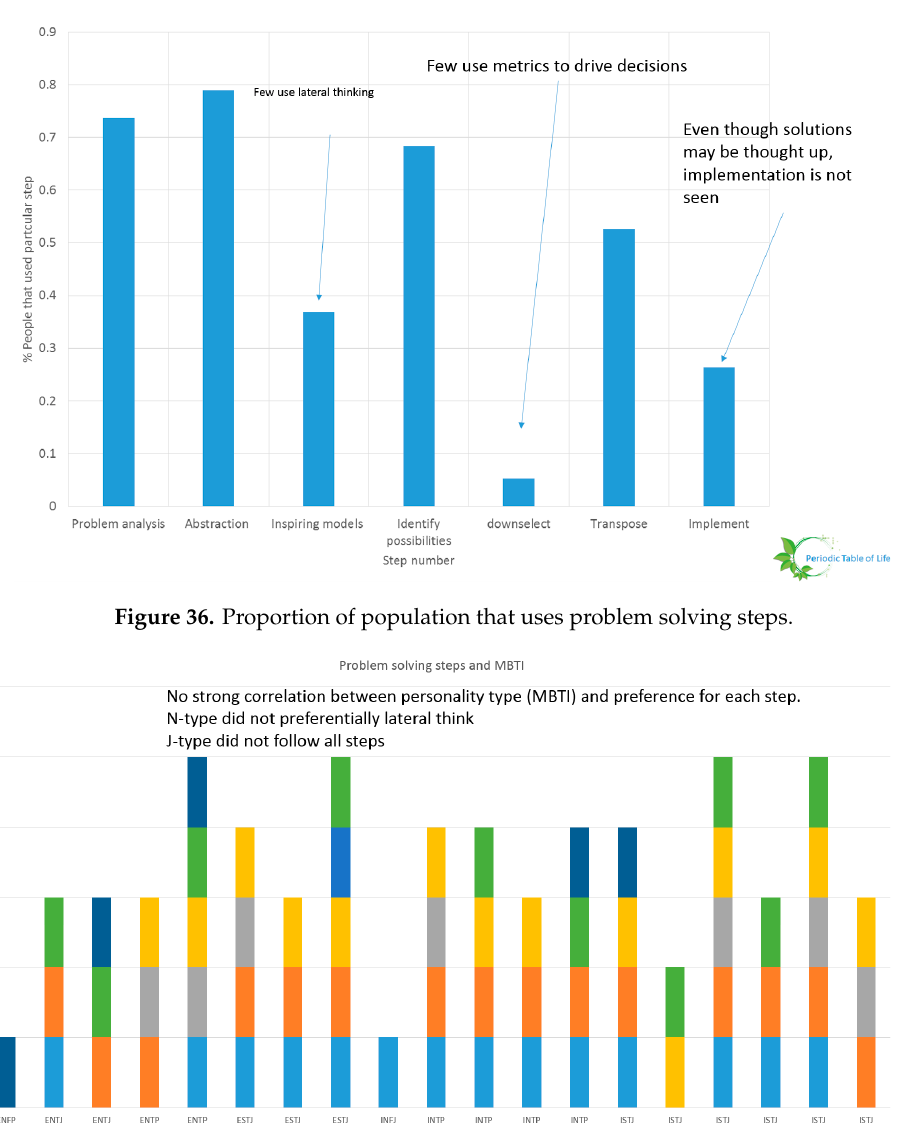
Figure 37. Problem solving step [40] and personality. No strong correlation observed.